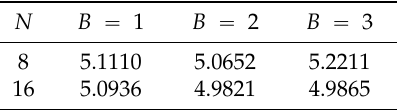
Table 8. Average Results on the 1997 AVIRIS Images (AC). Table 9. Average Results on the 1997 AVIRIS Images (PAQ8).